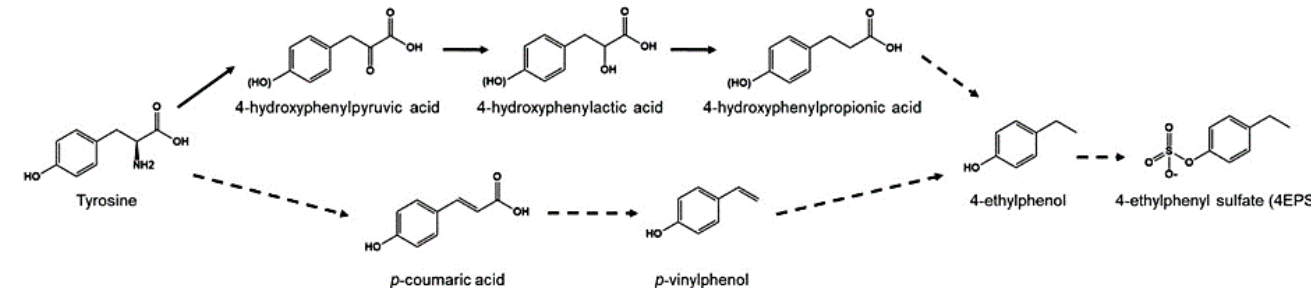
Figure 3. Formation of 4-ethylphenyl sulfate (4EPS) from tyrosine. Solid arrows show established reactions, and dotted arrows represent expected reactions.